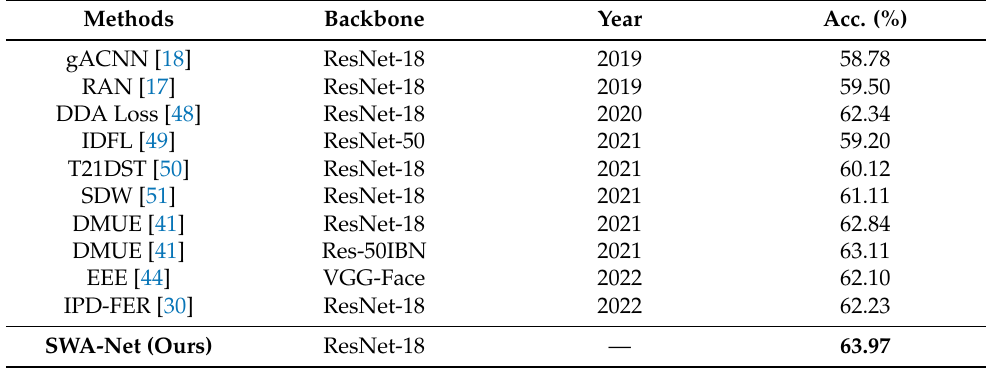
Table 8. Comparisons with the state-of-the-art methods on the AffectNet dataset. Since the AffectNet dataset is extremely unbalanced, we used an undersampling